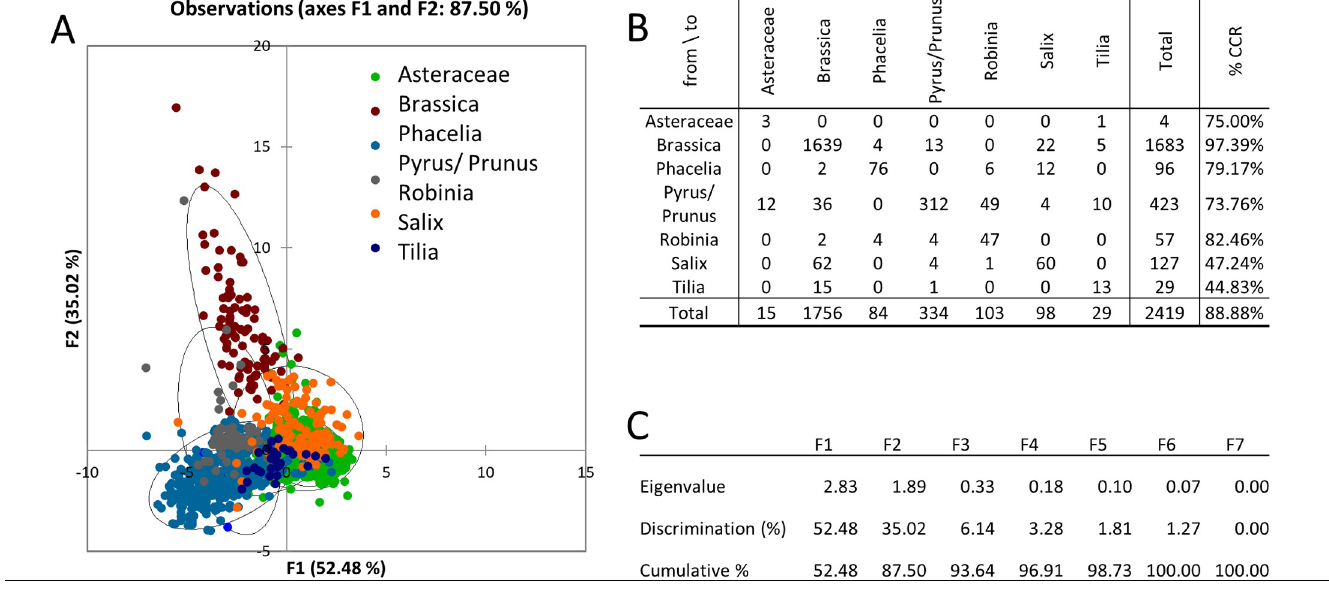
Fig 7. BF analysis (A), confusion matrix for the estimated taxon (B), and eigenvalues table